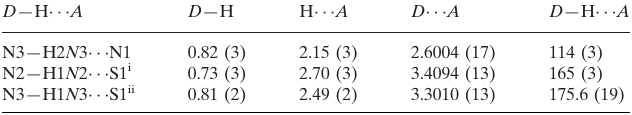
Hydrogen-bond geometry (A˚ , (cid:2) ). D —H (cid:3)(cid:3)(cid:3)